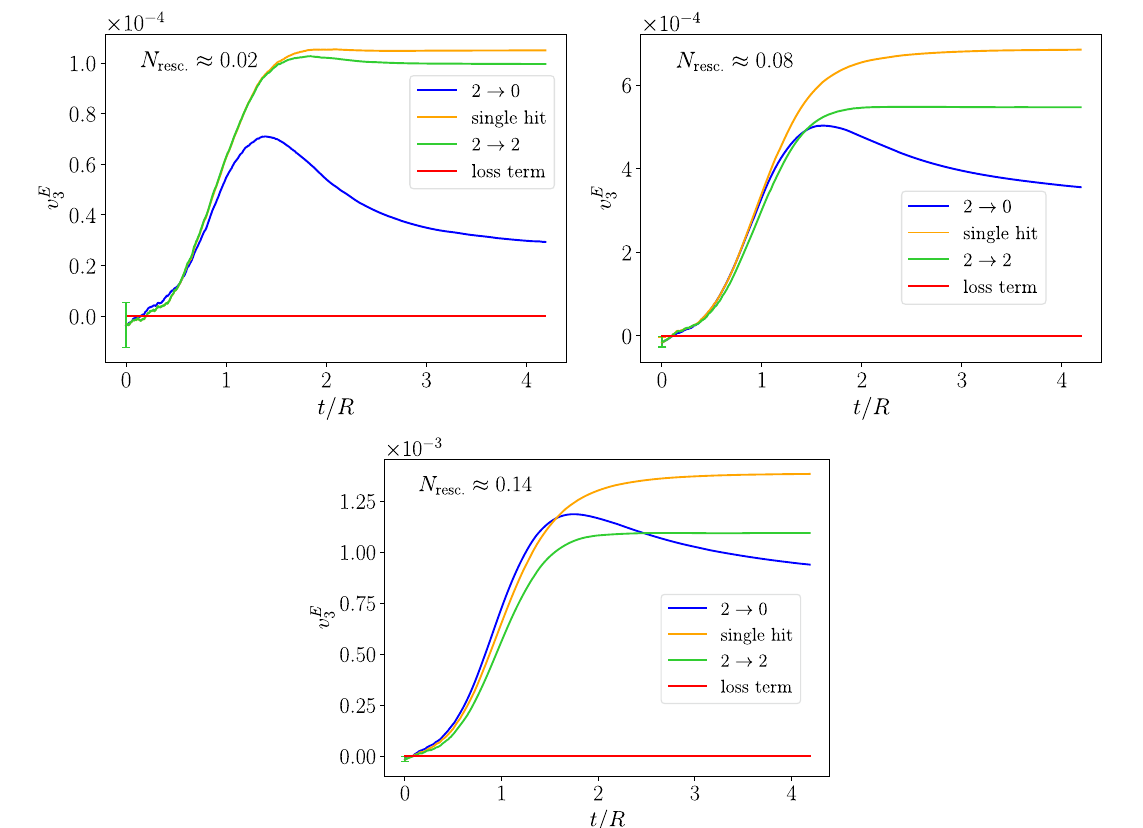
insys- the 2 → 0 collision kernel, and the orange curves for the single-hit 3 = 0 is the output of the analytical model. The constant red line v E 3